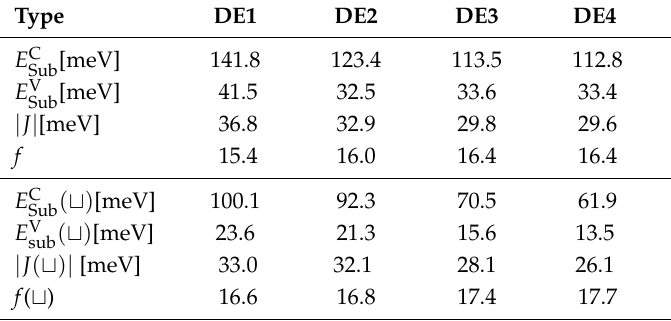
Figure 3. ( a ) Influence of Al interdiffusion ∆ E Al / E (cid:116) and the quantum corrections in ( b ) the confinement Q Q (= ∆ E Al ( a y / a x ) / ∆ E Al ( 1 ) − 1 ) and ( c ) the fine-structure splitting ∆ µ Al / ∆ µ (cid:116) in percent, energy ∆ E Al Q Q Q on the asymmetries of the confining potentials of the four DE QD species (DE1, circles; DE2, rectangles; DE3, triangles; and DE4, pluses). Table 1. Calculated quantum confinement characteristics of the four species of GaAs/Al 0.3 Ga 0.7 As DE